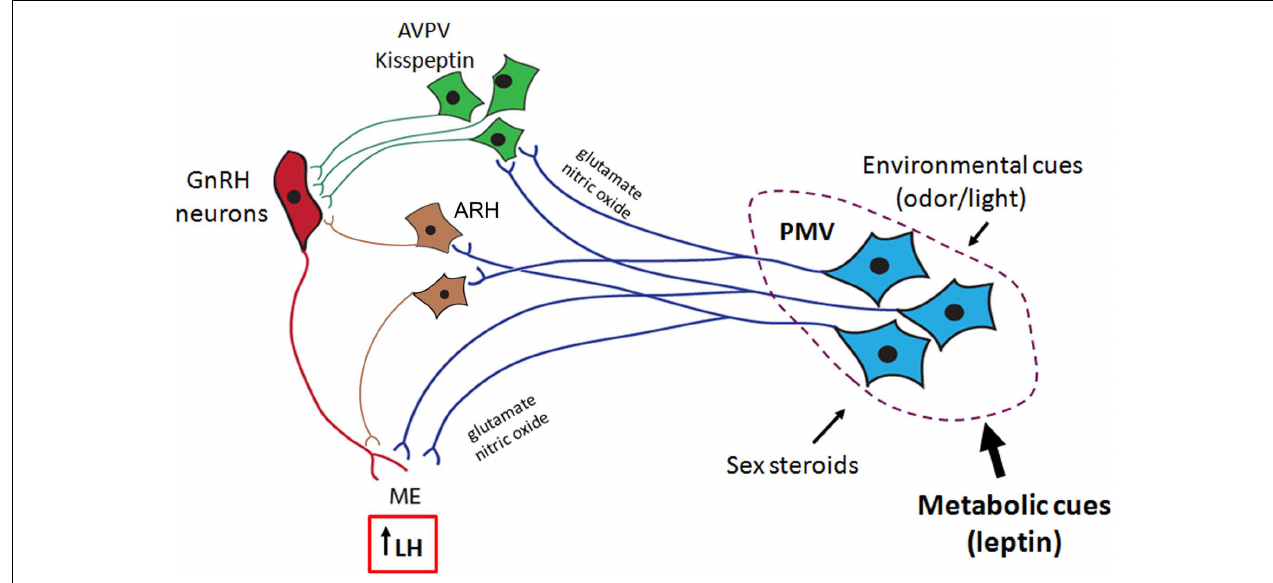
(e.g., glutamate and nitric oxide) and directly project to the anteroventral periventricular nucleus (AVPV), to the arcuate nucleus (ARH), and to gonadotropin-releasing hormone (GnRH) neurons. Once stimulated, PMV neurons activate the target sites inducing GnRH release and LH secretion from the pituitary